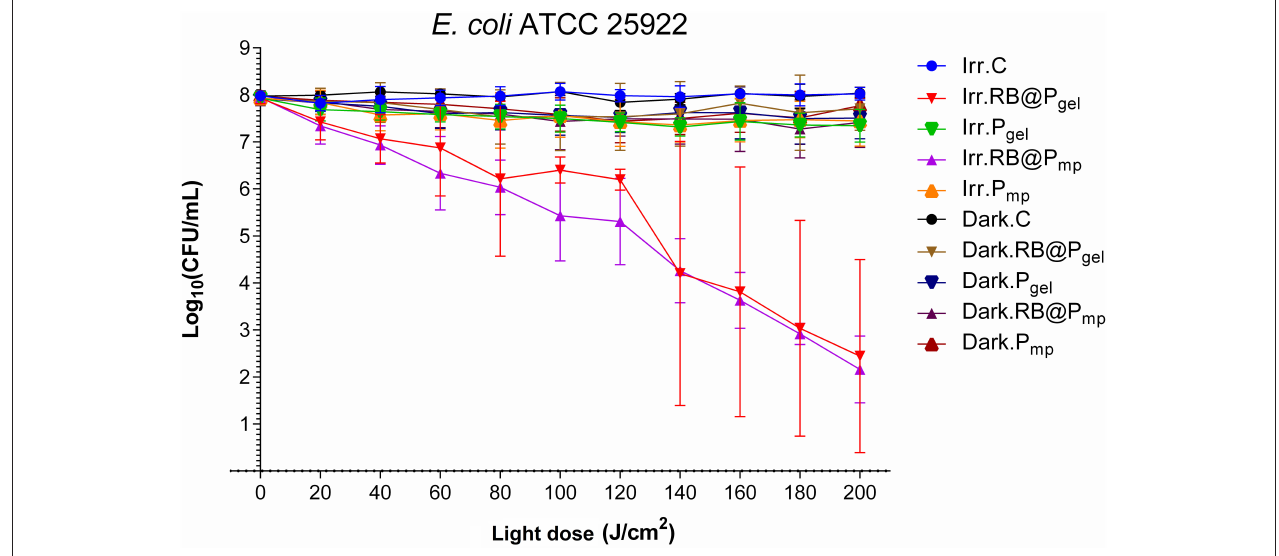
FIGURE 3 | Survival curves corresponding to the photodynamic inactivation of Escherichia coli . Every point is the average of three independent experiments. Error bars correspond to the standard deviations. Legend titles: Irr , irradiated samples; Dark , controls in the darkness; C , control, only microbial suspension; RB@P gel , Amberlite ® IRA-400 (P gel ) loaded with Rose Bengal (RB); P gel , P gel resin without RB; RB@P mp , Amberlite ® IRA-900 (P mp ) loaded with RB; P mp , P mp resin without RB.